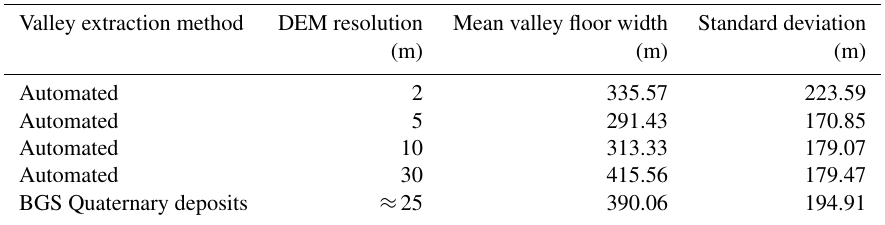
Figure 6. Hillshade of the River Tweed showing the valley floor widths extracted using the automated method (black) and those derived from the BGS Quaternary maps (red). The valley centreline is shown in blue. The left zoomed-in region (panels 1 and 2) shows an example of where the automated method is wider than the BGS Quaternary but picks up the break-in-slope transition to the hillslopes. The right zoomed-in region (panels 3 and 4) shows an example of where the two datasets are consistent. The coordinate system is WGS UTM zone 30N. Table 1. Mean and standard deviation of valley floor widths calculated from Weardale at varying DEM resolutions and from automated valley floor mapping compared to valley floors mapped from the BGS Quaternary